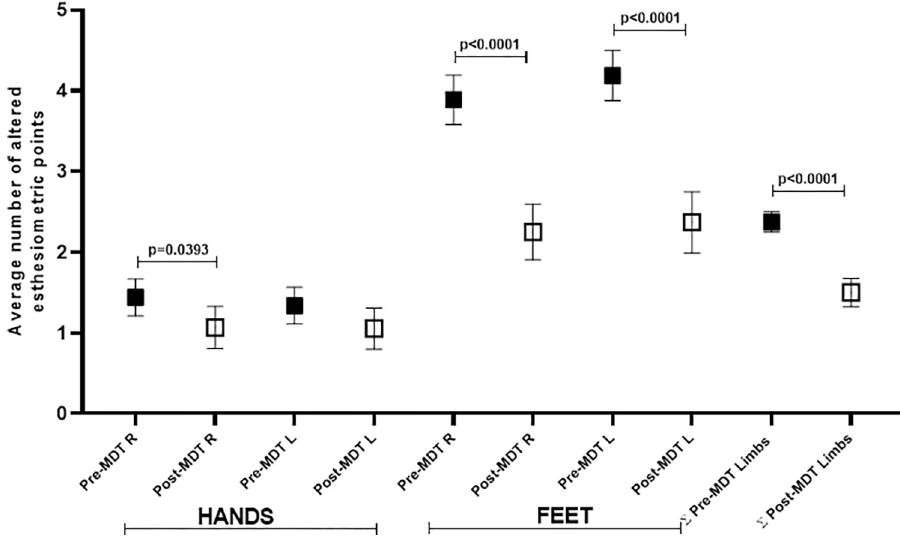
Fig 5. Evolution of the averages of the sum of the number of altered points detected by SWM-test performed on the right and left hands and feet of each patient when compared at diagnosis and at the end of WHO MDT.